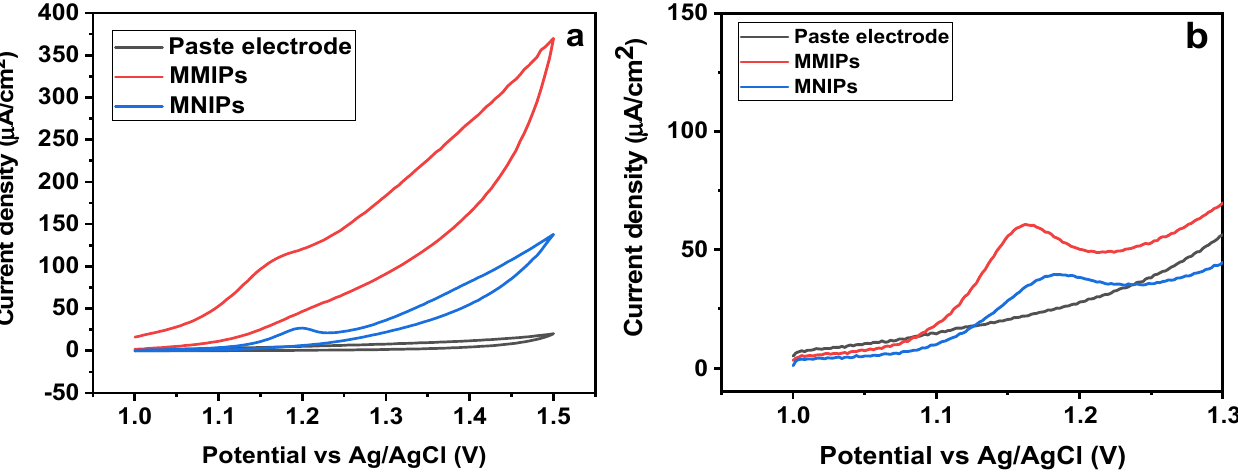
Figure 8. ( a ) CV for MMIPs, MNIPs, and Blank ( b ) SWAdASV for MMIPs, MNIPs, and Blank.